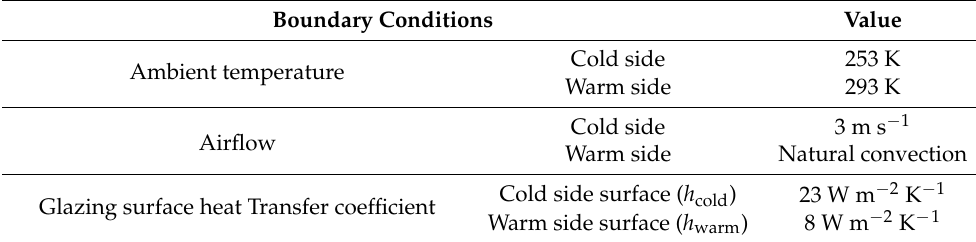
Table 2. Boundary conditions of the CVG